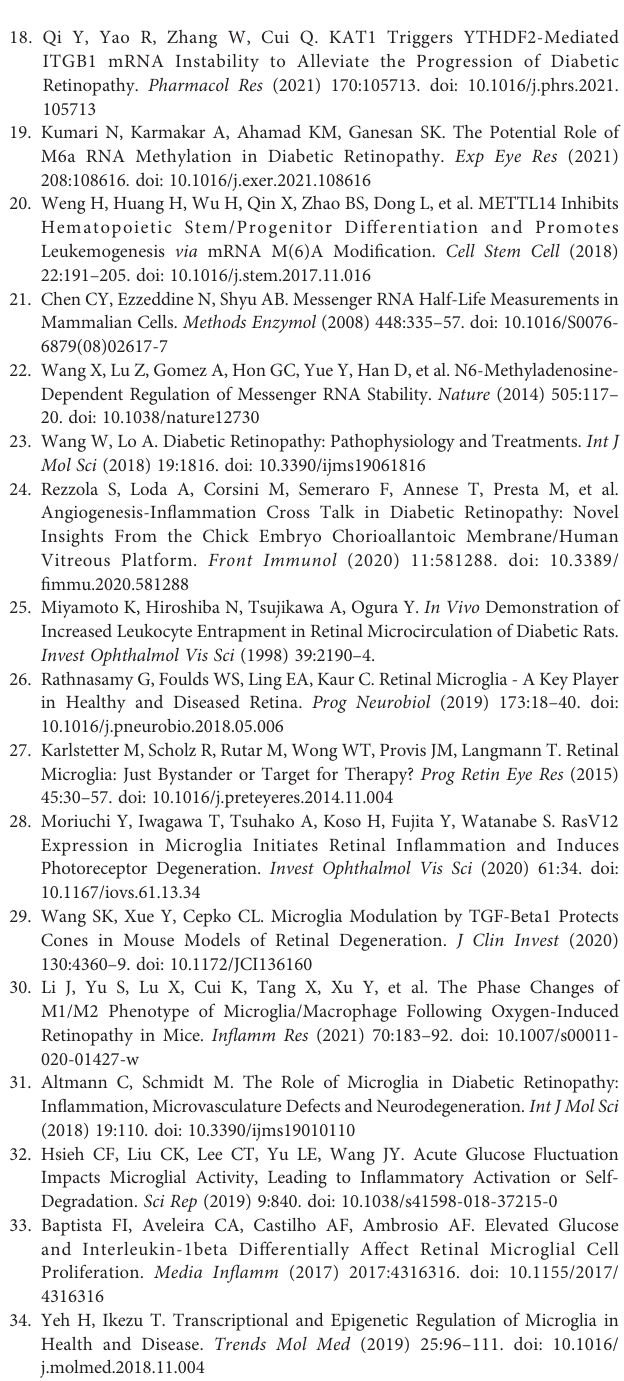
Supplementary Figure 1 | Function ef fi ciency ofLv-A20 andOE-A20. (A) Lv-A20 inhibited the A20 mRNA level compared to the Lv-NC. (B) Lv-A20 inhibited the A20